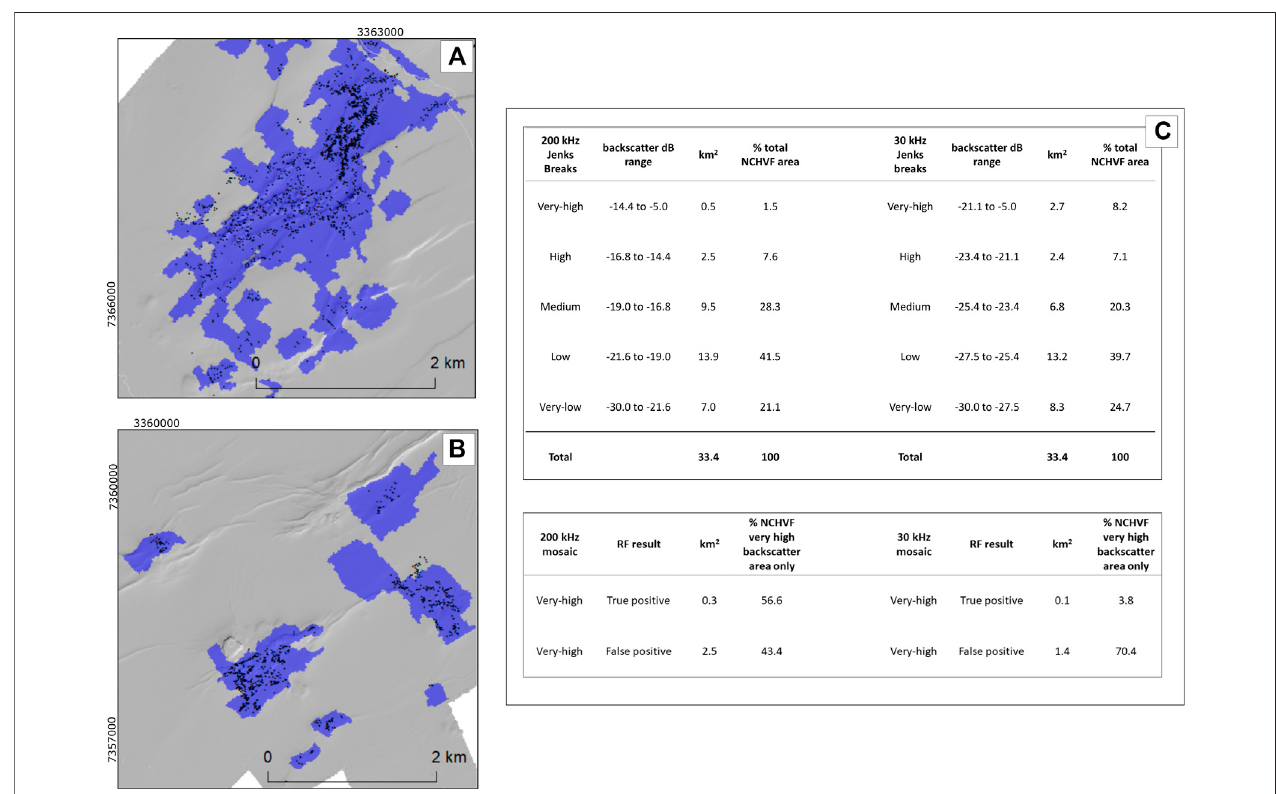
FIGURE10| Finalmodelpredictionsforthebestperformingmodelsof (A) NorthCalypsoHVF(SP46)and (B) SouthCalypsoHVF(SP75)withseeplocations(black dots) overlain, alongside (C) segment area and very-high backscatter area confusion matrix results for the best performing NCHVF model.